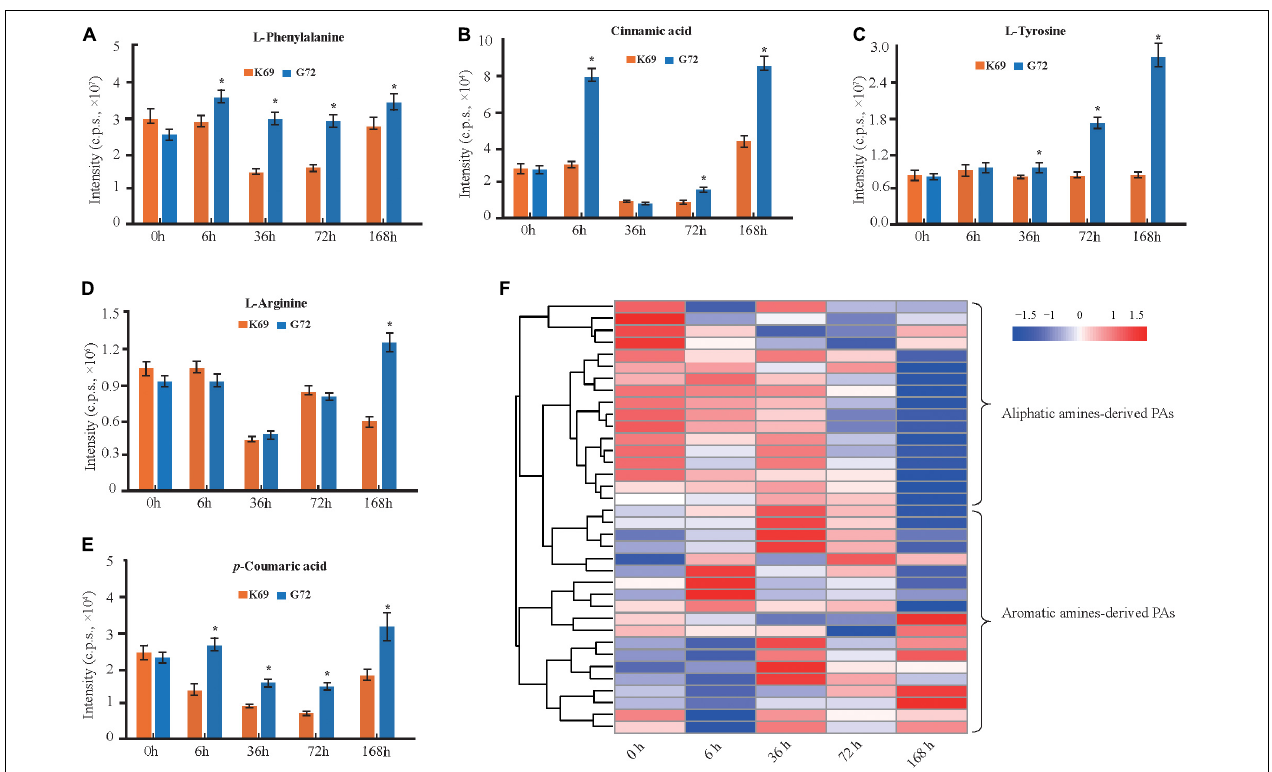
FIGURE 3 | DAMs related to PAs and its precursors were compared in K69 and G72 line during powdery mildew treatment. The levels of PAs precursors (A) L -phenylalanine, (B) cinnamic acid, (C) L -tyrosine, (D) L -arginine, and (E) p -coumaric acid in both of lines. The bars shown as SD with triplicate repeats. * Indicates significant difference ( P < 0.05, according to t -test). (F) Heat map visualization of PAs by comparison between K69 and G72 lines under PM infection and the non-stress control at 0, 6, 36, 72, and 168 h time